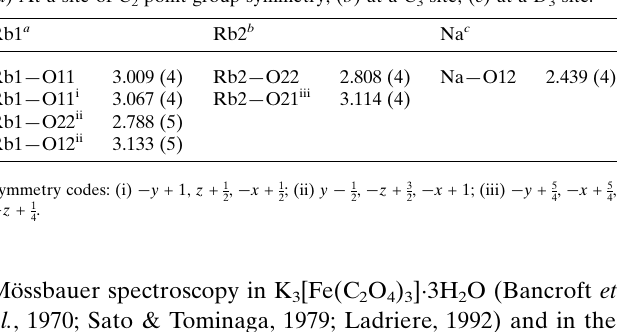
Table 2 Bond lengths (A˚ ) around the alkali metal ions in NaRb 5 [Fe(C 2 O 4 ) 3 ] 2 P 4 3 32 enantiomer..